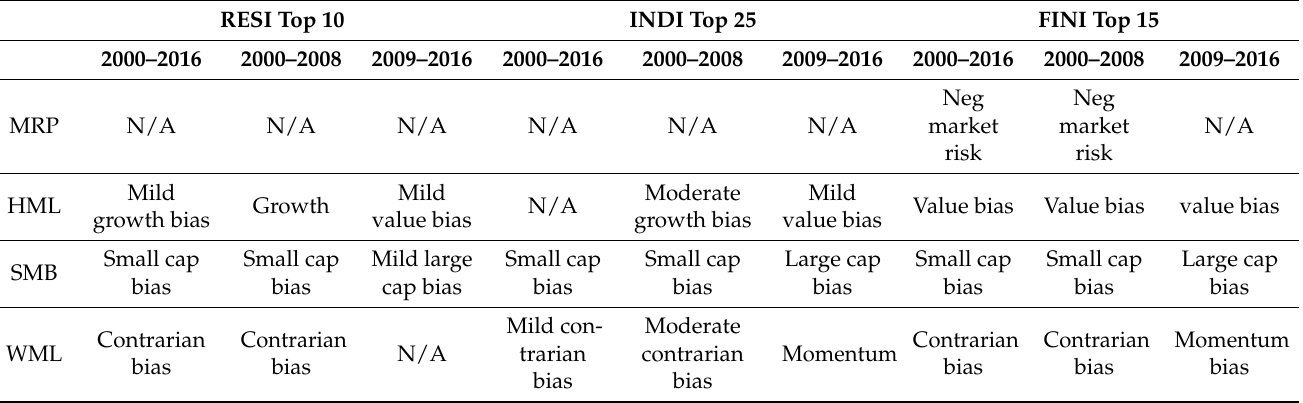
Table 8. Summary of market anomalies present in the four-factor